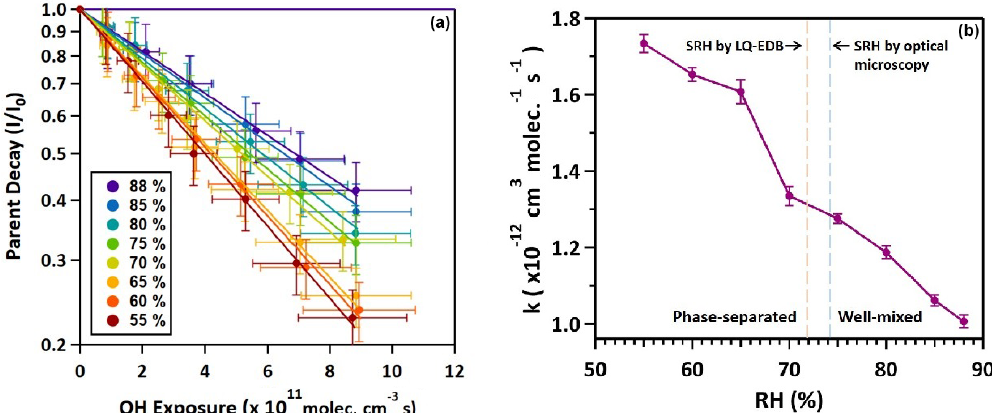
Figure 5. (a) Normalized parent decay of 3-MGA/AS aerosols (OIR = 1) as a function of RH; (b) the effective second-order heteroge- neous OH reaction rate constant ( k ) plotted against the relative humidity (RH) for the heterogeneous OH oxidation of 3-MGA/AS aerosols (OIR =